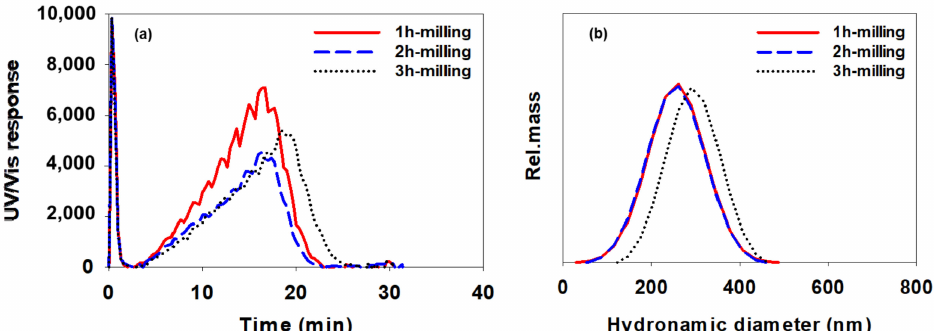
Figure 12. AsFlFFF fractograms ( a ) and size distributions ( b ) of CB dispersions prepared with SMA-3000. All AsFlFFF conditions were the same as those in Figure 10. Table 5. Particle diameters determined by AsFlFFF for the CB dispersions prepared with three different types of SMA